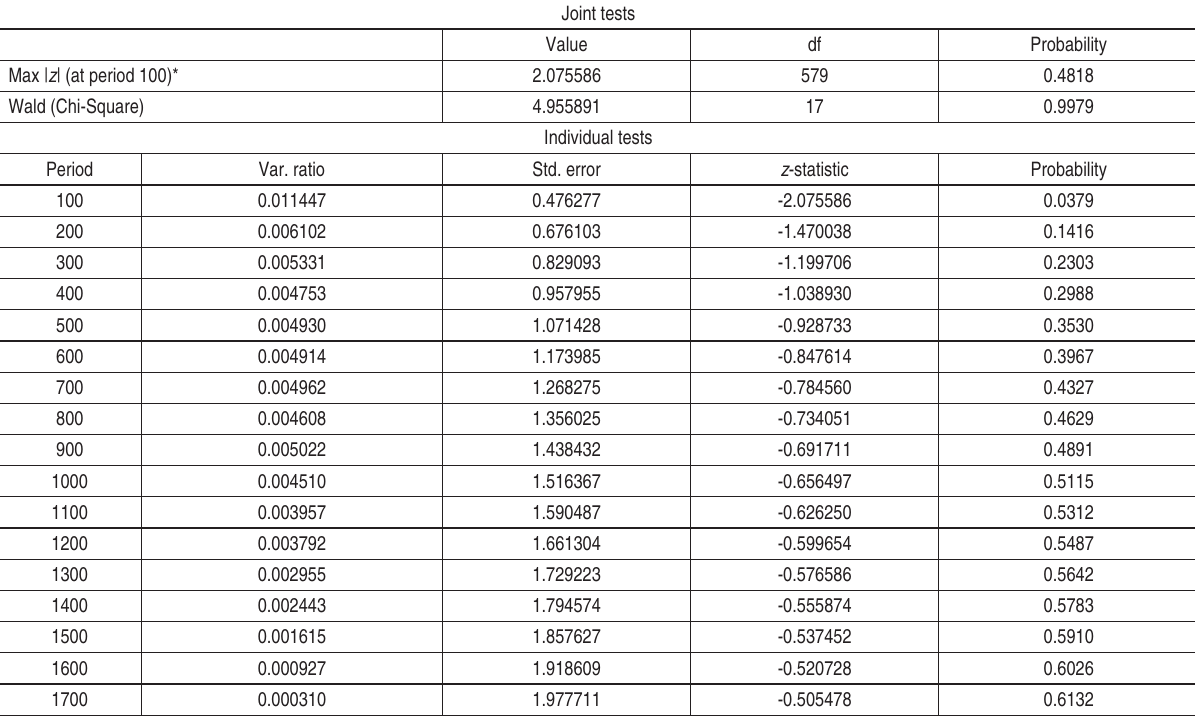
Table 5. Variance ratio test of the NSE ASI (daily